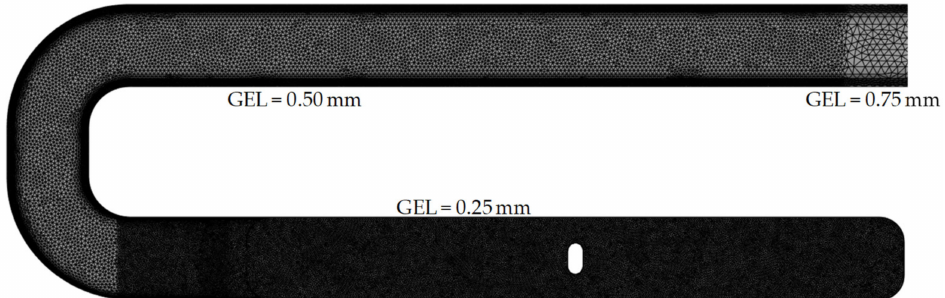
Figure 12. Final combined mesh with different GEL chosen for the MRD-parameter variation.